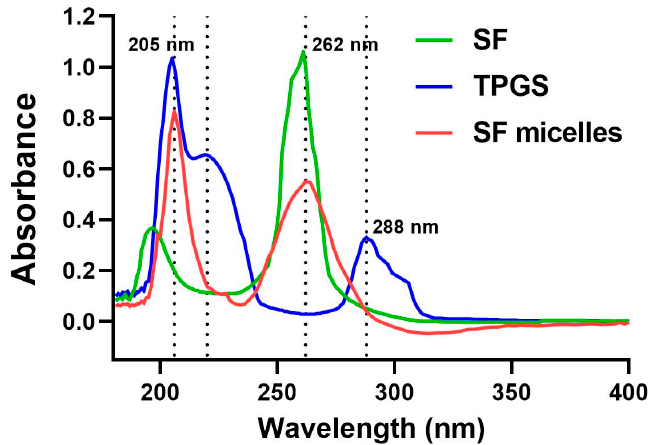
Figure A3. Ultraviolet scanning spectrum of SF, TPGS and SF micelles. Table A1. Characterization of SF micelles with different mass ratios of SF:TPGS (n = 3, mean ± SD). Sample